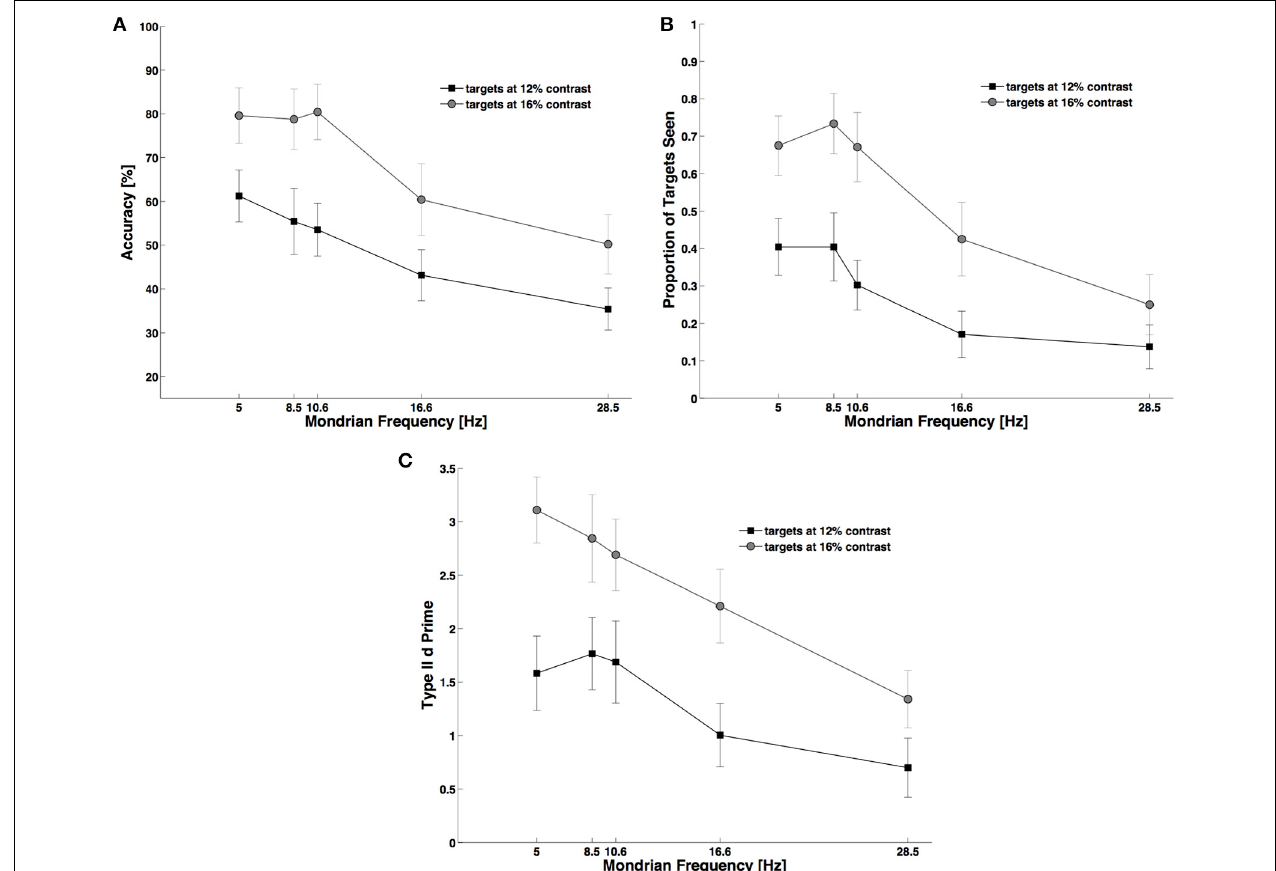
FIGURE 3 | Experiment 2. During CFS higher Mondrian frequencies generated stronger suppression of targets and a decrease in subjects’ performance. The same decaying trend equally affected: objective performance (A) , subjective reports of visibility (B) , and metacognition